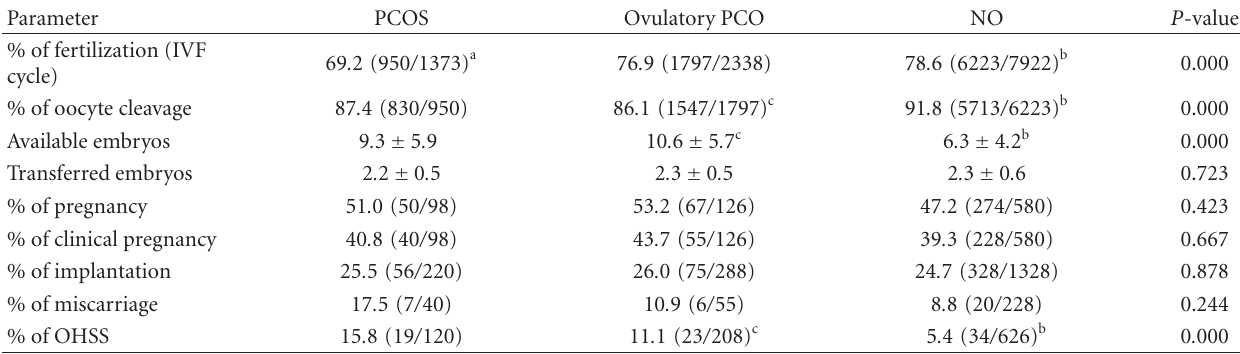
Table 3: Comparisons of IVF-ET